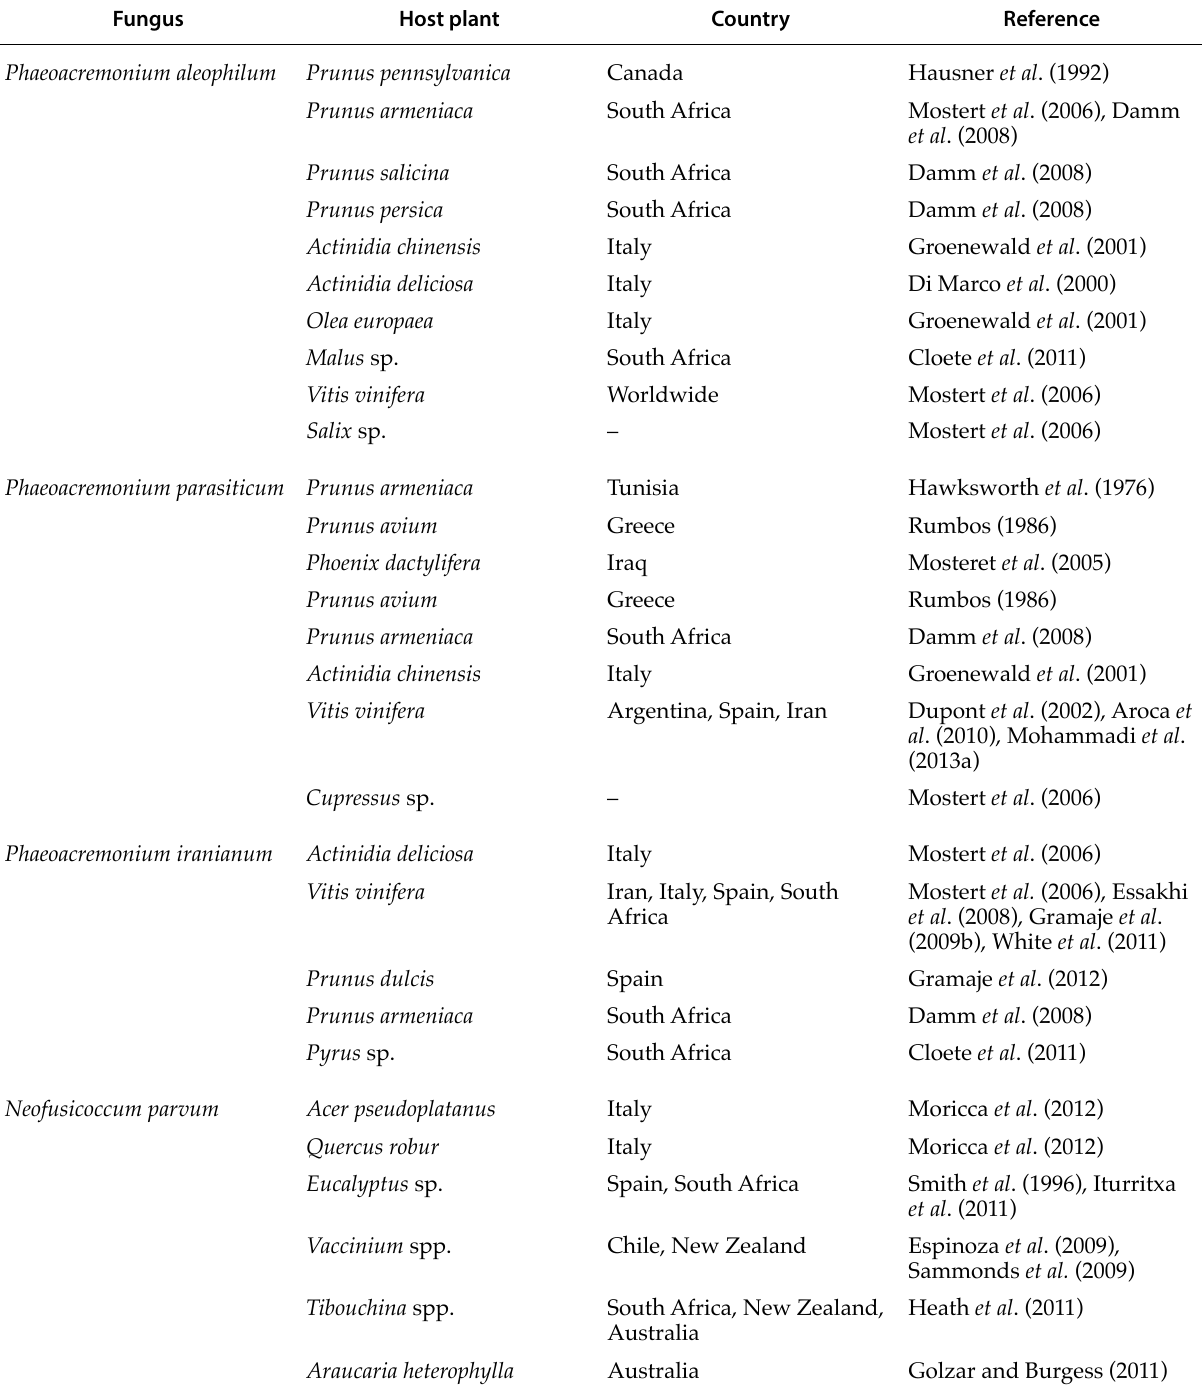
Table 3. Host plants and worldwide distribution of three Phaeoacremonium and two Botryosphaeriaceae species associated with cypress